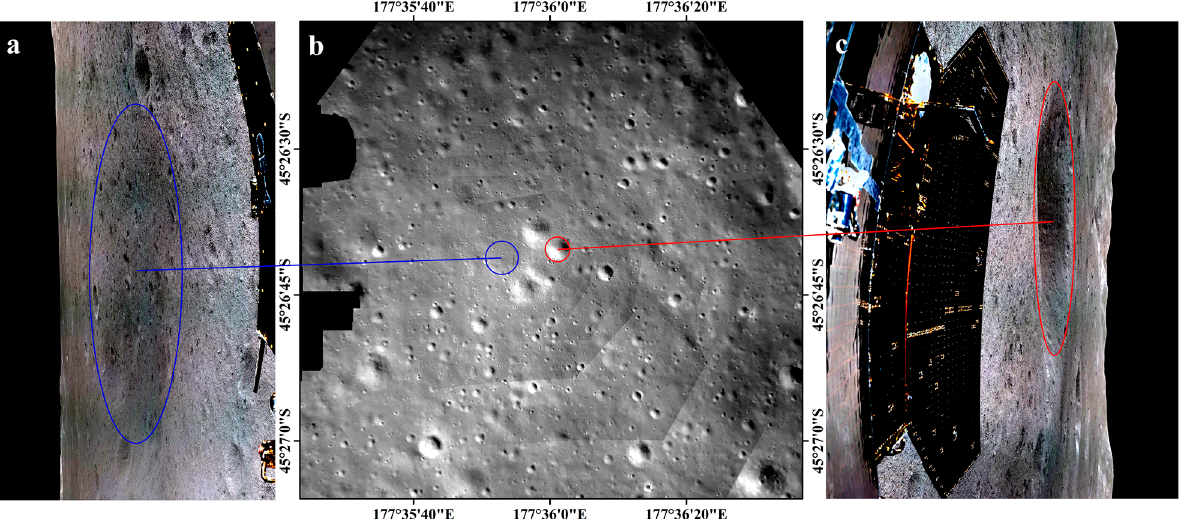
Figure 5. Comparison of impact craters on the LCAM mosaic image ( b ) and the TCAM images ( a , c : cylindrical projection). Circled in red and blue are two impact craters with different degradation levels (red circles are C3 type impact craters and blue circles are C4 type impact craters) shown in LCAM mosaic image and in TCAM images, respectively.